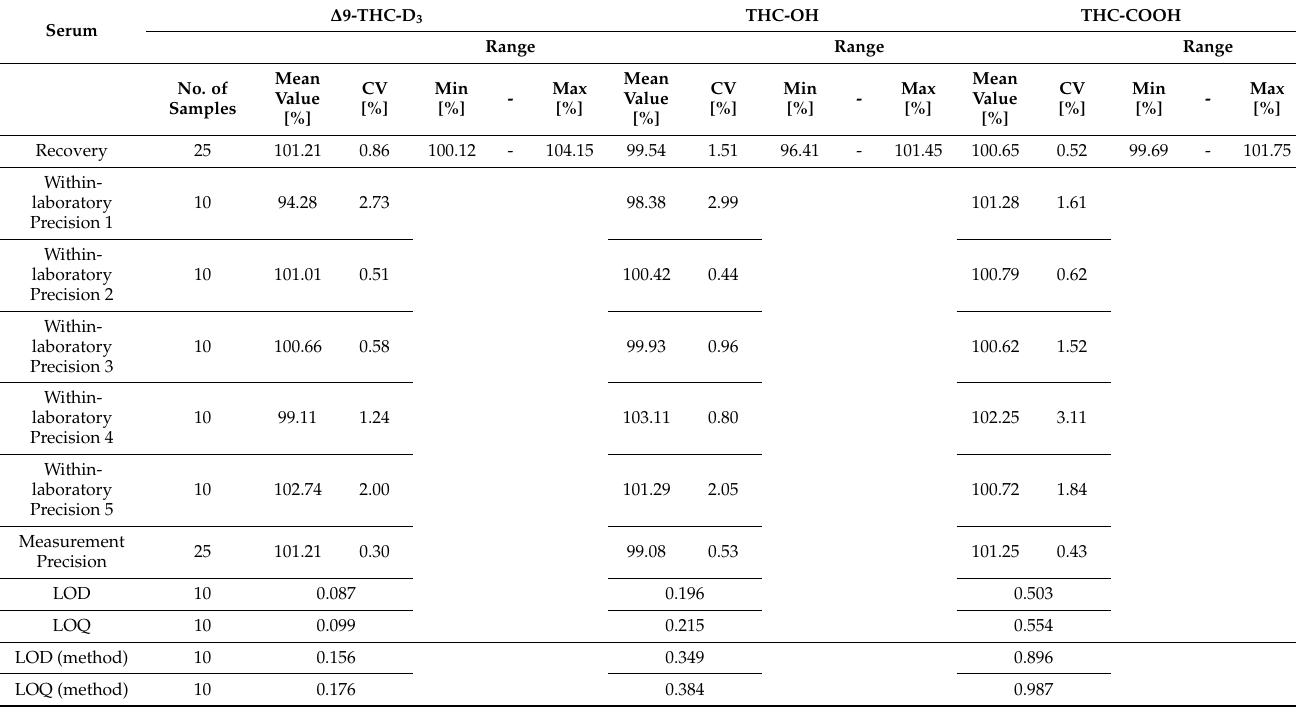
Table 1. Results of Method Validation Cannabinoid Determination from Serum.